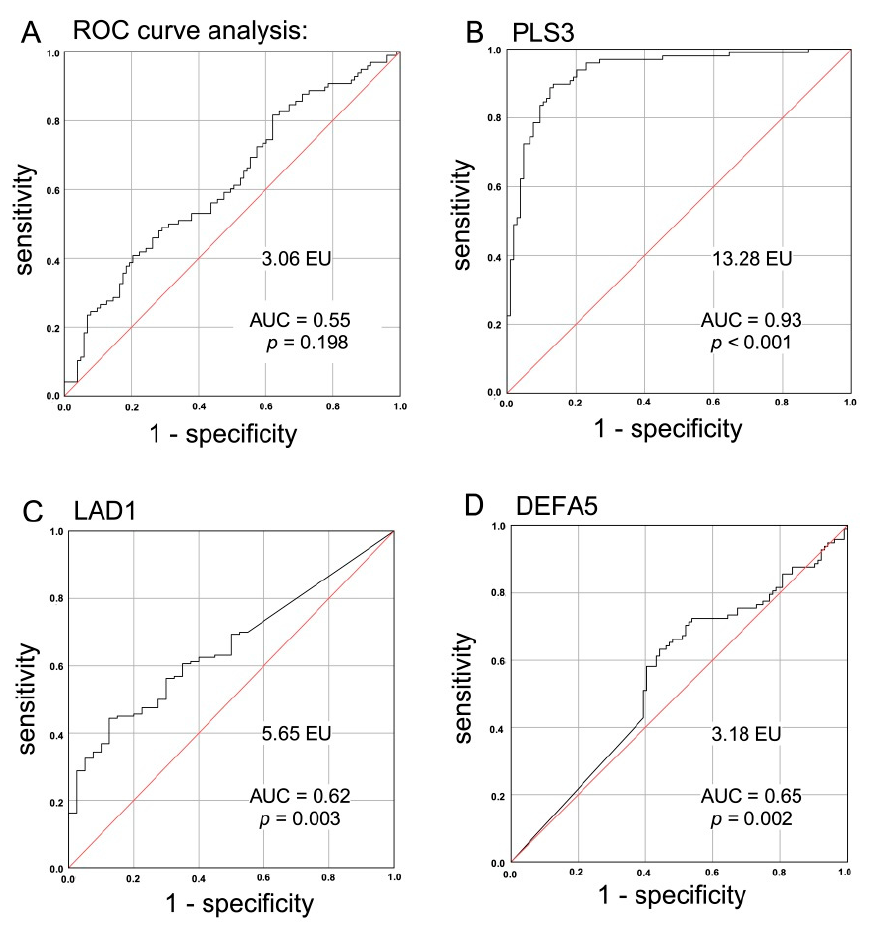
Figure 5. ROC curve analysis of CTC-associated markers for validation of the suitability of either marker for discrimination of malignant and benign colorectal diseases. Expression levels of ( A ) CK20, ( B ) PLS3, ( C ) LAD1, and ( D ) DEFA5 in healthy controls, IID patients, and CRC patients were subjected to ROC curve analysis with respect to the discriminatory power between the variables “malignant disease” versus “benign disease” and “healthy”, respectively, with the exception of DEFA5, where the discriminatory categories were chosen to be “diseased” (CRC + IID) versus “healthy”. Using the ROC curve data, the Youden index J was calculated by the equation J = sensitivity + specificity—1 as the point with the best sensitivity and specificity, from which the specific cut-off values in [EU] were calculated that are mentioned in the figure. AUC = area under the